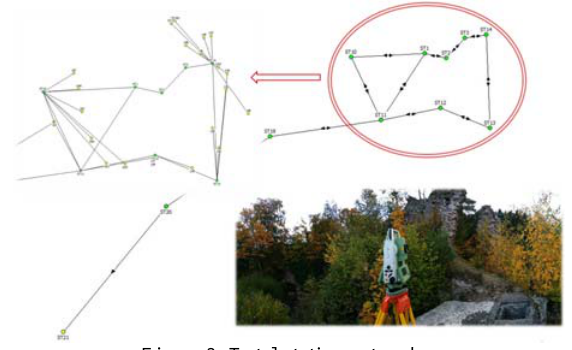
Figure 3: Total station network